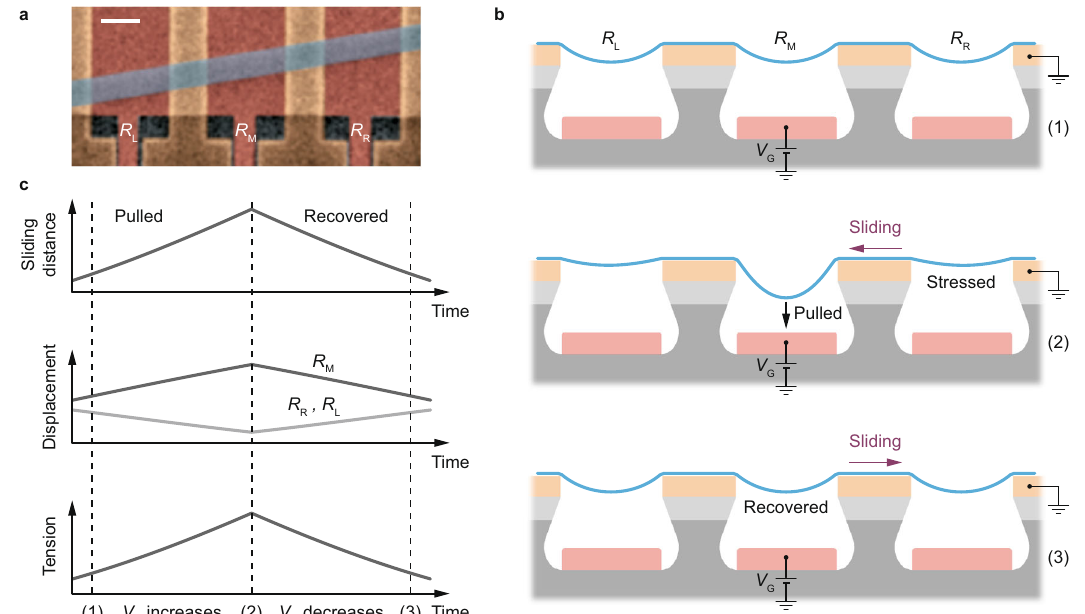
Fig.5|Physicsofthereversiblesliding.a SEMimageobtainedbyzoomingoutof the area shown in Fig. 1a, revealing three mechanically connected resonators, R L , R R M ,and R .Theresonatorinvestigatedinthetextisthemiddleone,labelledas Scale bar: 1 micrometer. b Schematic of the reversible sliding. As extra membrane lengthisfedinto the middletrenchinresponse to electrostatic pulling (state (1)to